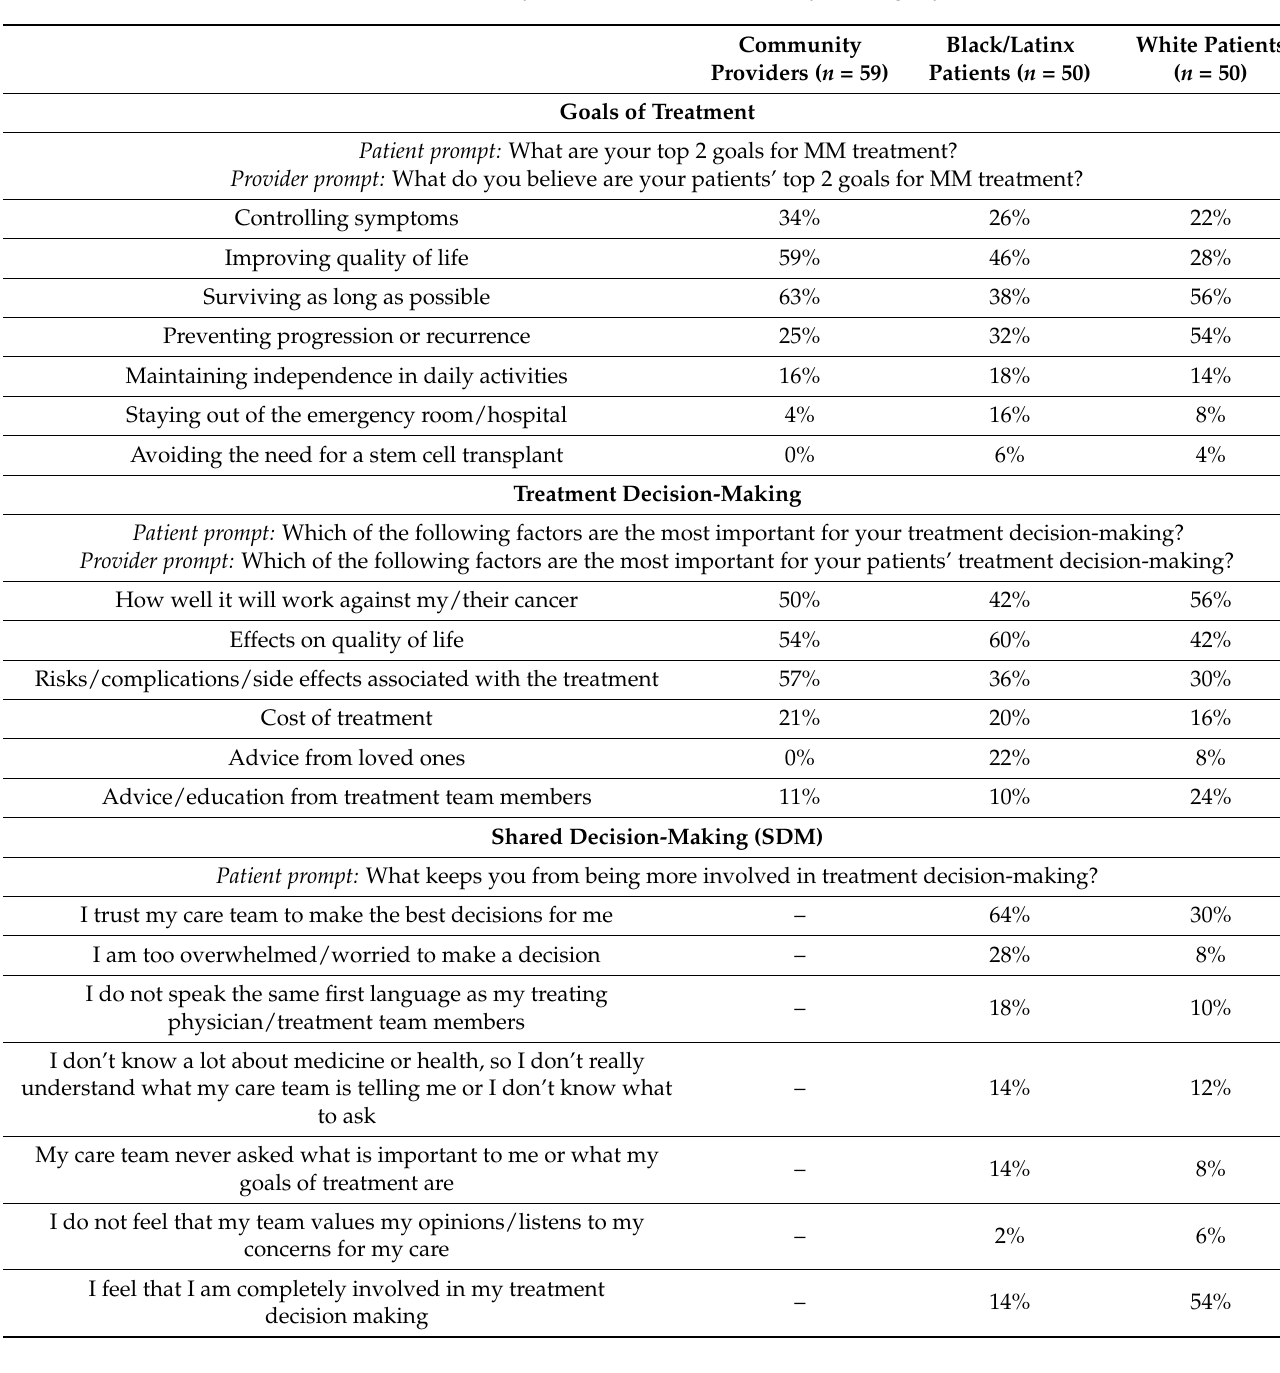
Table 4. Community Patient and Provider Survey Findings by Patient